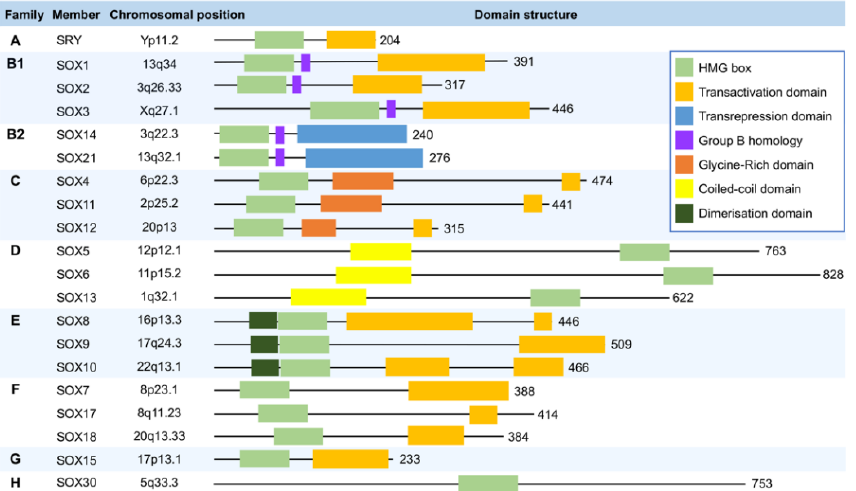
Figure 1. Schematic diagram of the chromosomal positions and domain structures of human SOX transcriptional factors. SOX family members are classified into eight subgroups based on the degree of sequence identity of the HMG motif, which is an evolutionarily conserved DNA-binding motif and is also a representative signature of the SOX family. Besides the shared HMG motif, different SOX members have their specific structure domains to achieve functional diversity. The chromosomal positions and domain structures of SOX members have been shown (Data referenced from Ref. [17] and website www.ncbi.nlm.nih.gov/gene/ (accessed on: 15 November 2021)). Abbreviations: SRY: Sex-determining region Y; SOX: Sex-determining region Y-related high-mobility group box; HMG: High-mobility group.